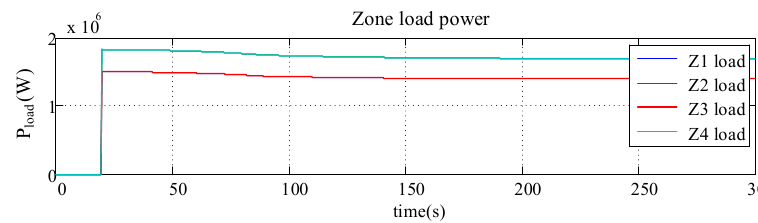
Figure 7. Case 1 PM torque, speed, and power.